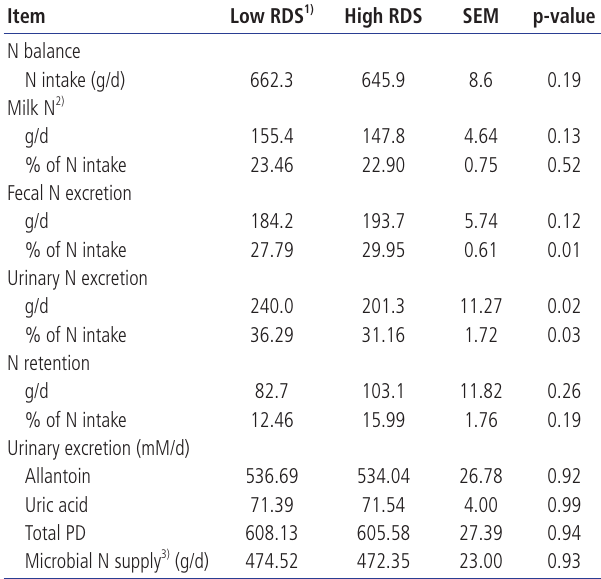
Table 5. The effects of dietary ruminally degradable starch levels on nitrogen utilization in dairy cows